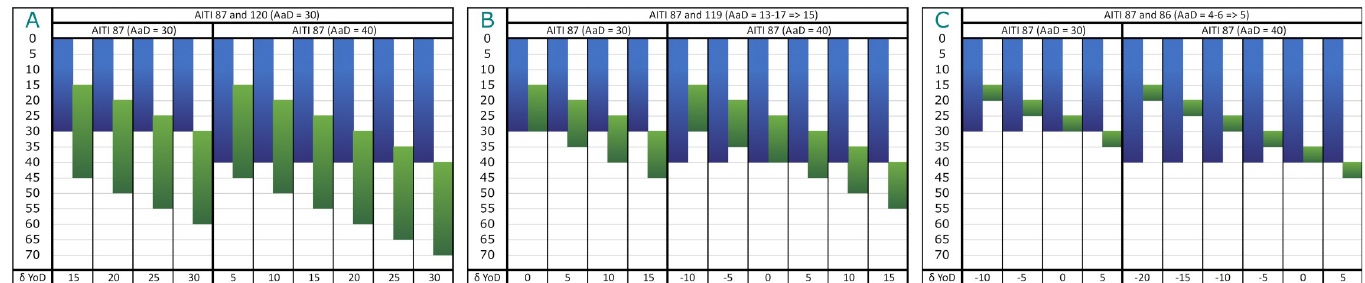
Fig 22. Compilation of scenarios of overlapping lifespans of the mother and her offspring. The possible lifespan of the mother (AITI_87) is depicted in blue, those of her sons (AITI_86, AITI_119 and AITI_120) are depicted in green. (A) mother and adolescent son AITI_120. (B) mother and subadult son AITI_119. (C) mother and subadult son AITI_86. δ YoD varies depending on the AaD estimations of the mother (30–40 years).